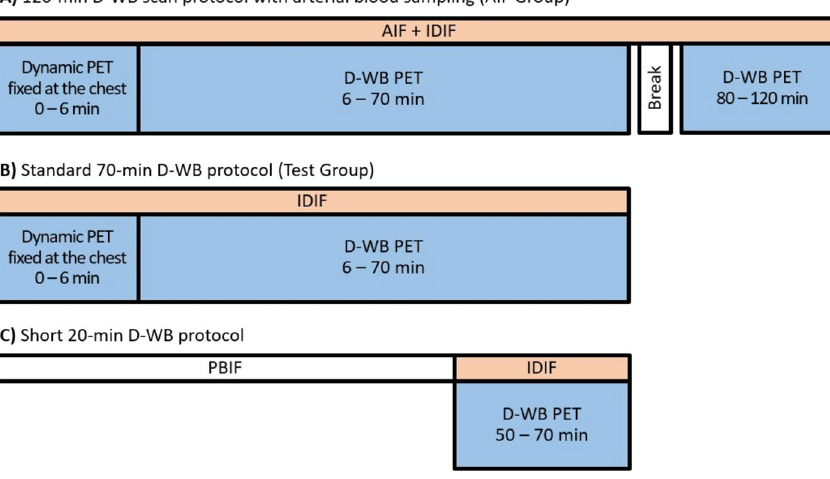
Fig. 1 D-WB PET scan protocols used in the study the input functions used for multiparametric imaging: + A 120-min D-WB PET scan protocol with simultaneous arterial blood sampling used for the AIF Group; B Standard 70-min D-WB PET scan protocol used for the Test Group; C Short 20-min D-WB PET scan